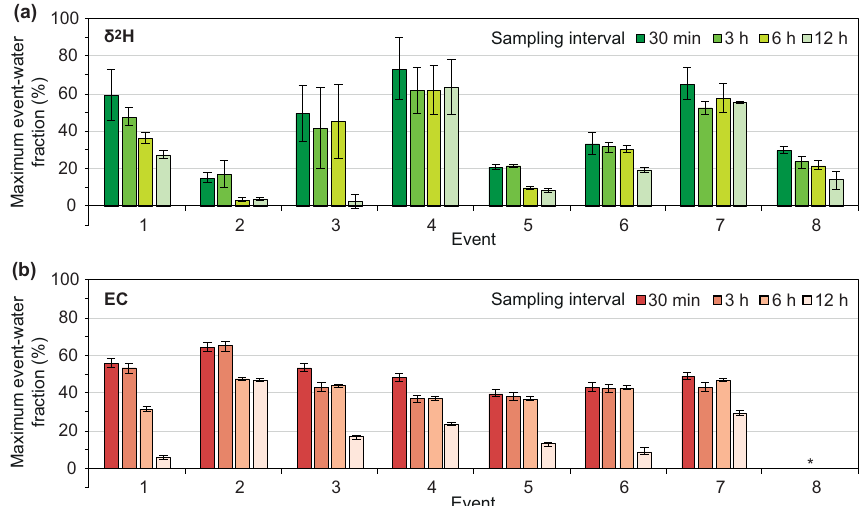
Figure 11. Maximum event-water fractions at sampling intervals of 30min and 3h, 6h, and 12h based on (a) δ 2 H and (b) EC. With lower sampling frequencies, the event-water fractions are often underestimated or become unrealistic, as the likelihood increases that the point of the largest δ 2 H or EC variations in streamflow will be missed (stream water δ 2 H and EC time series were subsampled at 3h, 6h, and 12h and daily intervals; concentrations of integrated bulk precipitation samples were calculated from the volume-weighted averages over the respective time interval). For Event 8, the wash-off of road salt resulted in unrealistic F E , max values based on EC ( ∗